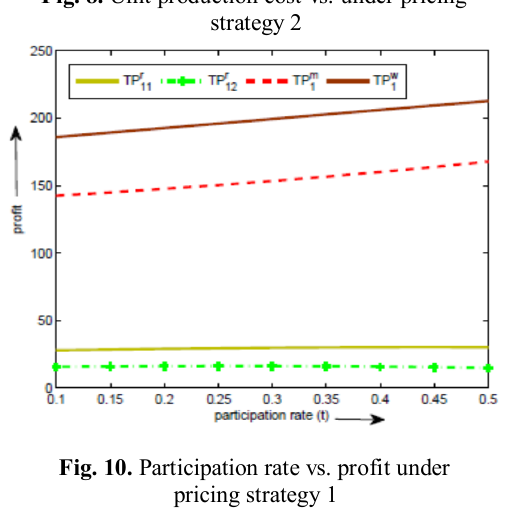
Fig. 7. Unit production cost vs. profit under pricing strategy 1